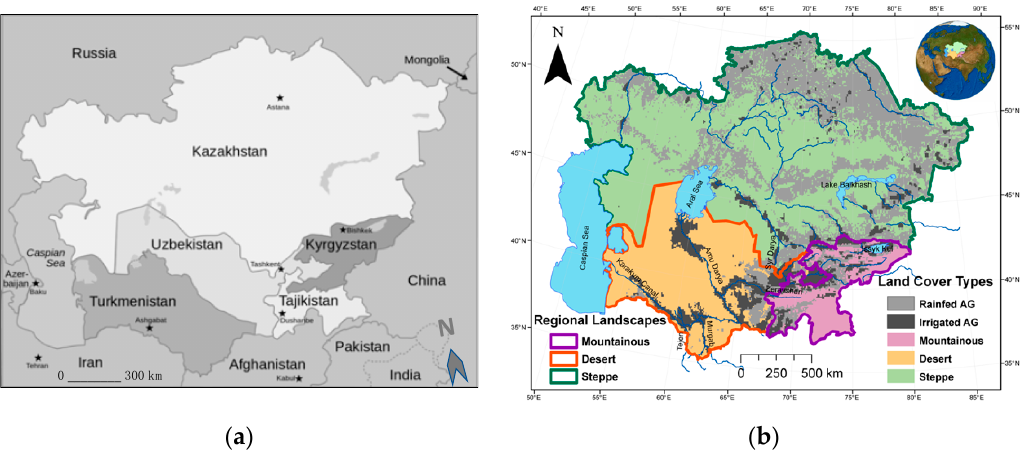
Figure 1. ( a ) Central Asian political map of countries (left) [14] and ( b ) environmental map (right) [15].